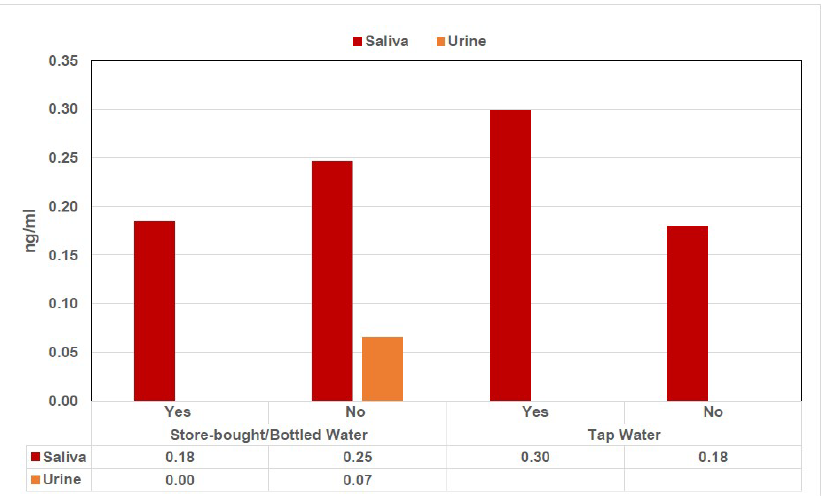
Figure 2. Elevated ( p < 0.05) microcystin/nodularin levels in saliva and urine by drinking water source. Sources not mutually exclusive; Store-bought/Bottled: saliva (yes, n = 48; no, n = 13); urine (yes, n = 22; no, n = 14); Tap water: saliva (yes, n = 9; no, n = 52). Urine MC/NOD was most prevalent and demonstrated the highest levels among in- dividuals consuming vegetables from local sources (1/2, 50%) (mean 0.23 ng/mL, SD 0.32) compared to those consuming vegetables from imported sources (0/10) (mean 0 ng/mL) or both local and imported sources (1/19, 5.3%) (mean 0.01 ng/mL, SD 0.05) ( p = 0.03; p = 0.0014) (Figure 3). Similarly, urine MC/NOD was most prevalent and levels highest among individuals consuming fruits from local sources (1/2, 50%) (mean 0.12 ng/mL, SD 0.17) compared to those consuming vegetables from imported sources (0/11) (mean 0 ng/mL) or both local and imported source (1/14, 7.1%) (mean 0.02 ng/mL, SD 0.06) ( p = 0.05; p = 0.04).